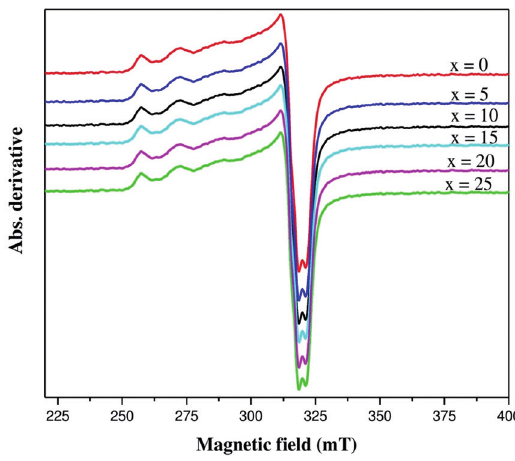
Figure 1: EPR spectra of Cu 2+ in the present glass system.